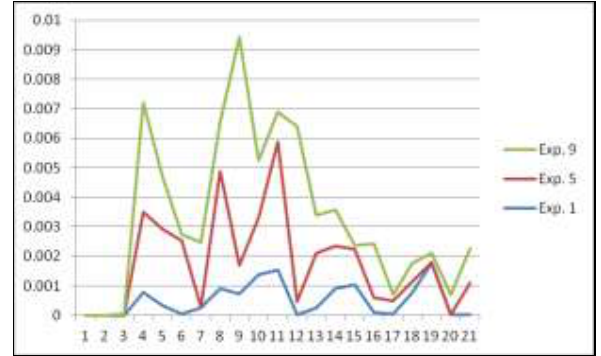
Figure 5 – Z C rms error at each PC.